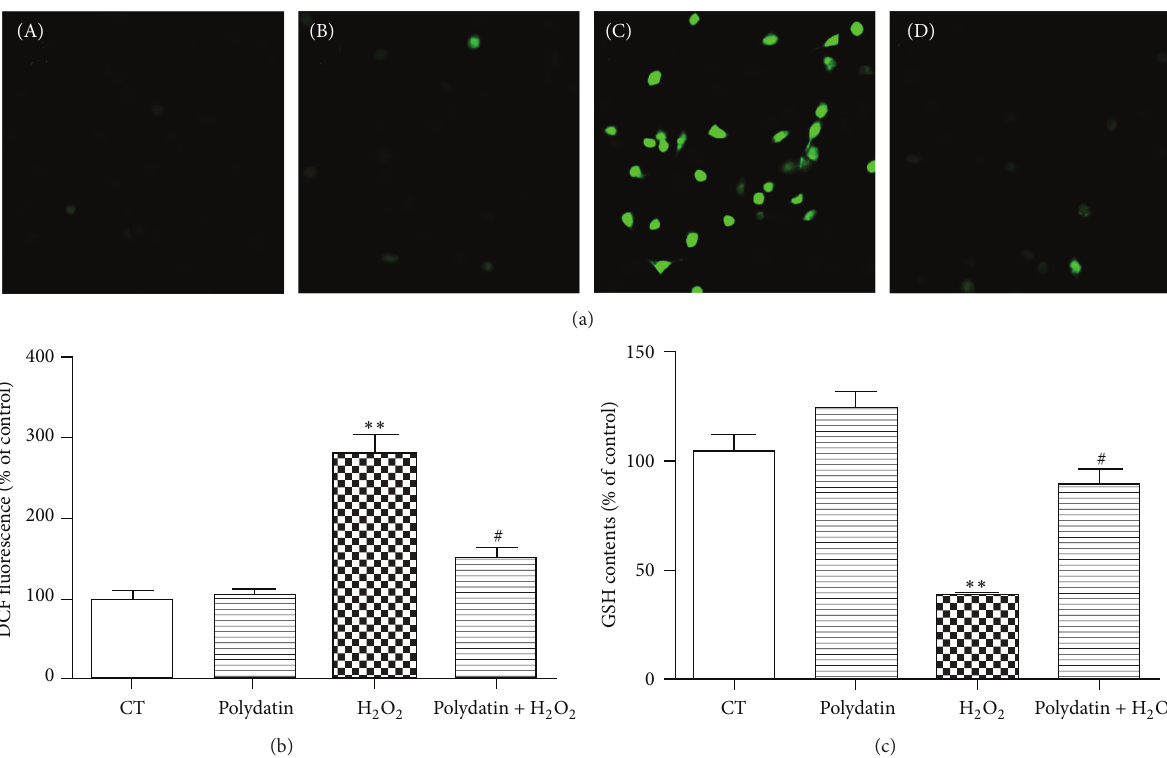
Figure 4: Polydatin scavenges ROS produced by H 2 O 2 . (a) ROS production induced by H 2 O 2 was detected by H 2 DCF-DA staining. (b) Quantitative analysis of DCF fluorescent intensity. (c) The level of GSH was measured using GSH assay kit. The basal contents of GSH in untreated control cells were taken as 100%. Data are collected from 3 independent experiments and presented as means ± S.D. One-way ANOVA followed by Tukey’s test. ∗ 𝑝 < 0.05 and ∗∗ 𝑝 < 0.001 versus control group; # 𝑝 < 0.05 versus H 2 O 2 -treated